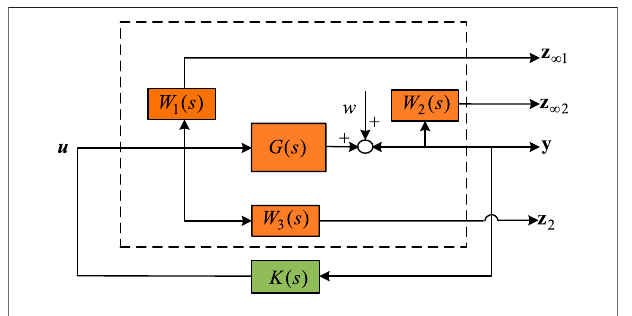
FIGURE 7 | Diagram of damping ratio ζ > cos θ area (Area D ).